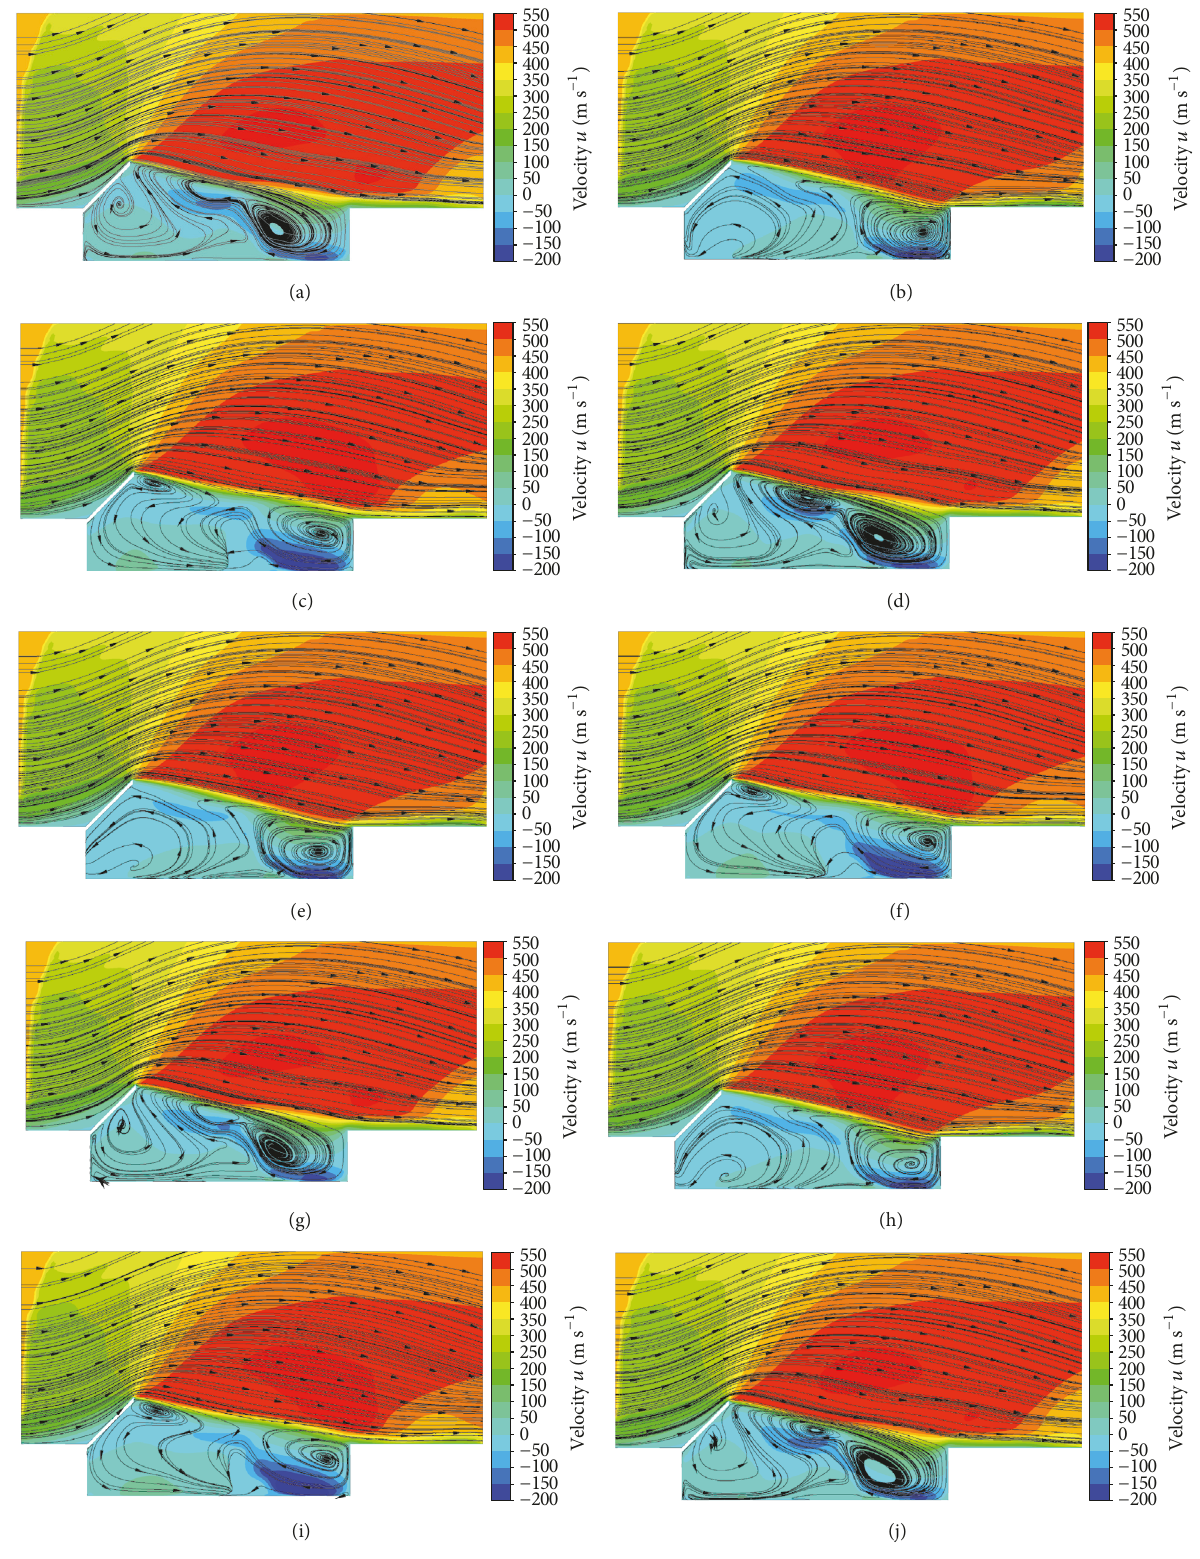
Figure 16: 𝑋 -velocity contours and streamlines for CP4 case (a) 𝑡/𝑡 𝑅 = 0 , (b) 𝑡/𝑡 𝑅 = 0.11 , (c) 𝑡/𝑡 𝑅 = 0.22 , (d) 𝑡/𝑡 𝑅 = 0.33 , (e) 𝑡/𝑡 𝑅 = 0.44 , (f) 𝑡/𝑡 = 0.55 , (g) 𝑡/𝑡 = 0.66 , (h) 𝑡/𝑡 = 0.77 , (i) 𝑡/𝑡 = 0.88 , and (j) 𝑡/𝑡 𝑅 𝑅 𝑅 𝑅